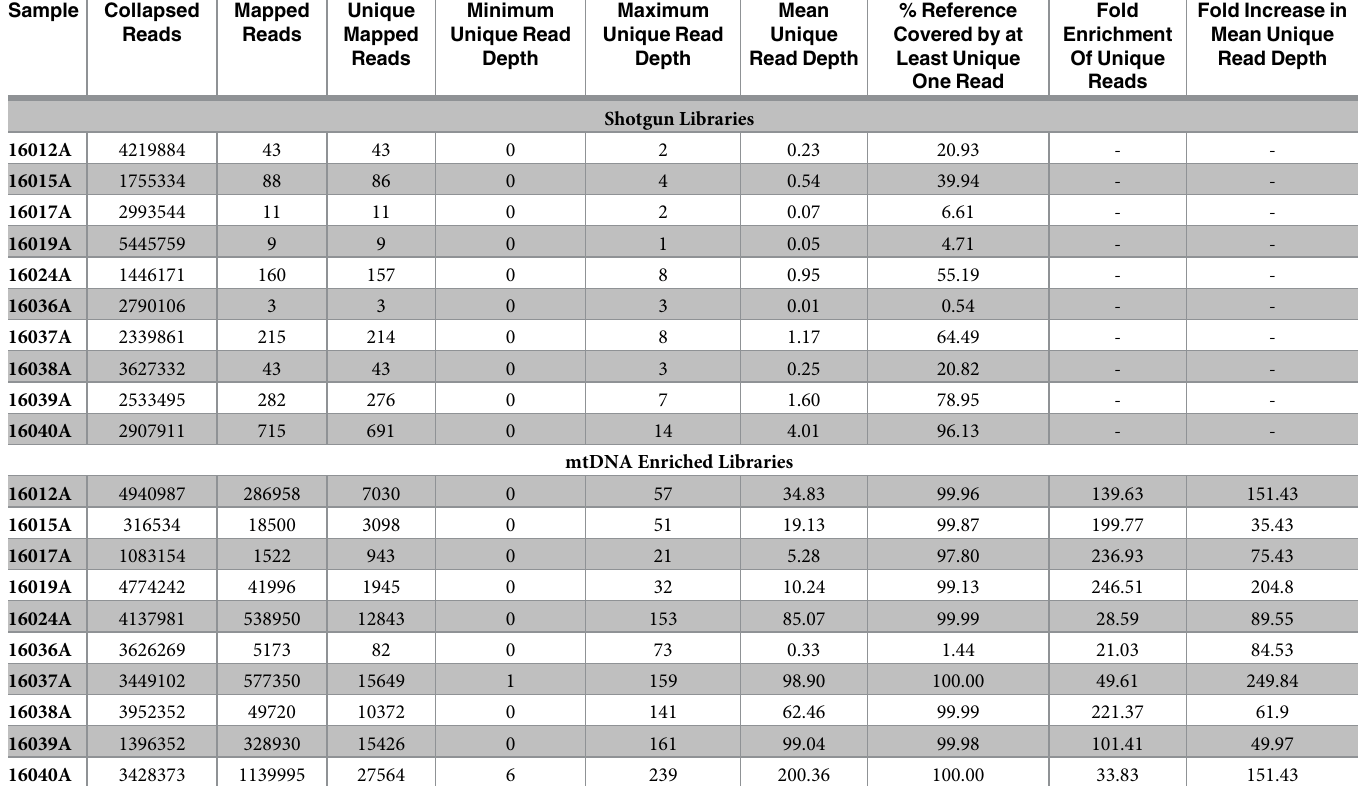
Table 4. Wombat mapping